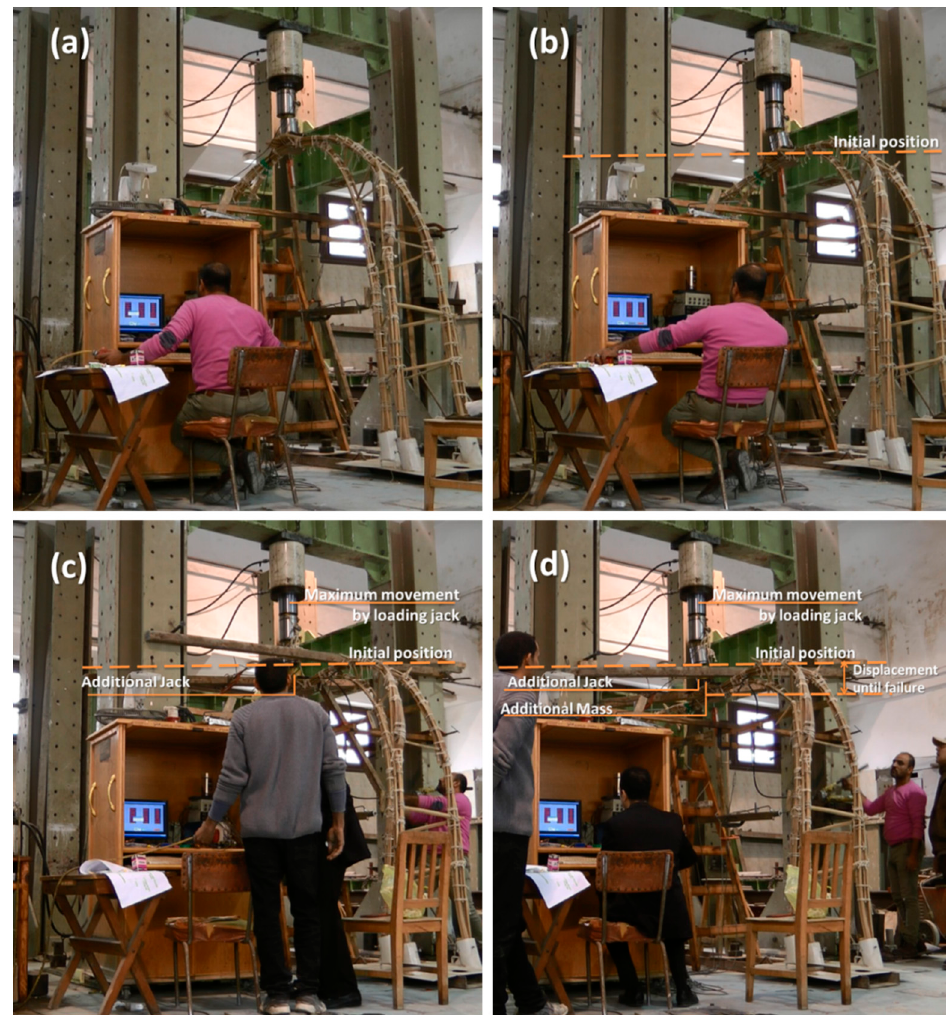
Figure 18. Experimentation of the third specimen. ( a ) Initial state before loading. ( b ) Reaching the maximum movement by loading jack for the 1st time: 250 mm. ( c ) Reaching the maximum movement by loading jack for the 2nd time. ( d ) Specimen at failure.